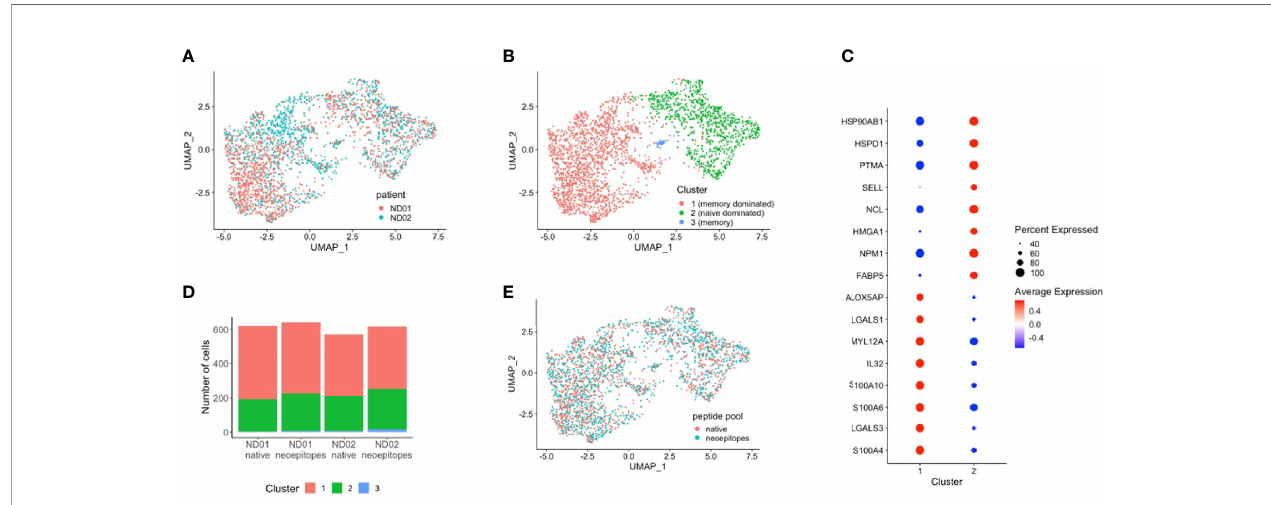
FIGURE 4 | PBMCs from subjects ND01 and ND02 were stimulated with native (proinsulin peptides: C13 – 32, C19-A3, C22-A5; GAD peptides: 115 – 125, 265 – 284) and neoepitopes [C-pep-IAPP1, C-pep-NPY, GAD 115 – 127 (120E), GAD 265 – 284 (272 cit)] and each patient/pool was labeled with a different hashtag as described in Methods . Antigen-responsive cells were identi fi ed by expression of CD154/CD69, and immune pro fi ling was subsequently conducted on single cells. Cells from subjects (A) ND01 and ND02 separate into (B) three clusters (0 – 3) based on gene expression similarity. (C) Clusters differ by expression of memory and naïve cell speci fi c genes. (D) Cells reacting to native and neoepitopes are similarly split between clusters and (E) have similar patterns of